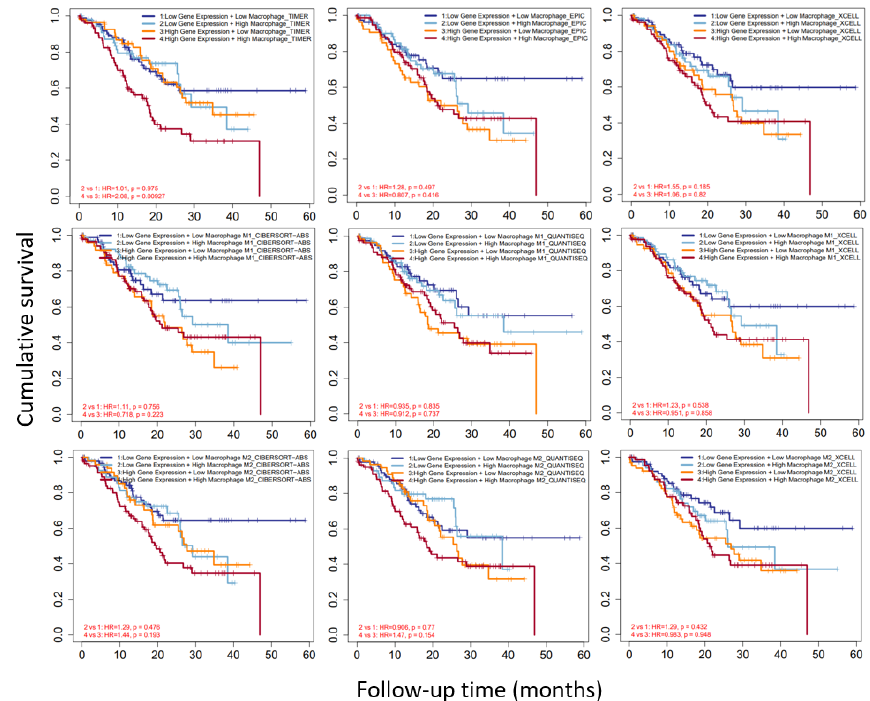
Figure 7. Correlation between CAST and the WNT family. +: significant positive correlation, WNT2 (rho = 0.139; p -value = 0.004); WNT3 (rho = 0.2; p -value < 0.001); WNT11 (rho = 0.336; p -value < 0.001); WNT2B (rho = 0.144; p -value = 0.003); WNT7B (rho = 0.186; p -value < 0.001); WNT8B (rho = 0.168; p - value < 0.001); WNT10B (rho = 0.183; p -value < 0.001). − : significant negative correlation, none.